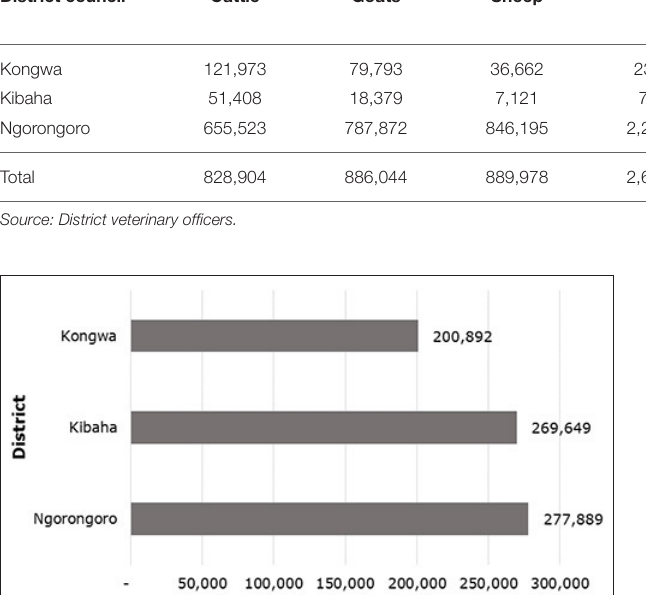
TABLE 5 | Field level human resources vs. livestock population in the selected district councils in 2019. District